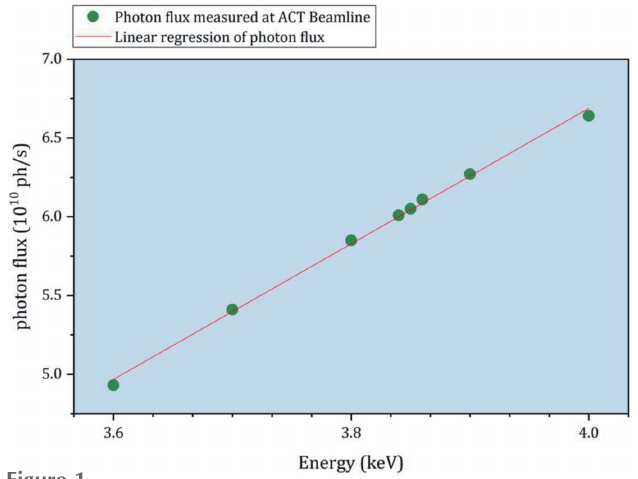
Figure 1 Current photon-flux conditions in the tender X-ray energy range at the ACT experiment. Synchrotron radiation beam path conditions from source to I 0 monitor (ionization chamber): 2.5 GeV storage-ring electron energy, average electron-beam current ’ 120 mA, 2 mm (h) (cid:5) 1 mm (v) front-end (white beam) slit aperture, cylindrical collimating first Si mirror, 250 m m Be vacuum protection plus 100 m m graphite thermal- protection window, Si h 111 i DCM crystal pair, toroidal focusing second Si mirror, 25 m m KAPTON window and synchrotron radiation beam spot size ’ 1 mm (cid:5) 1 mm.